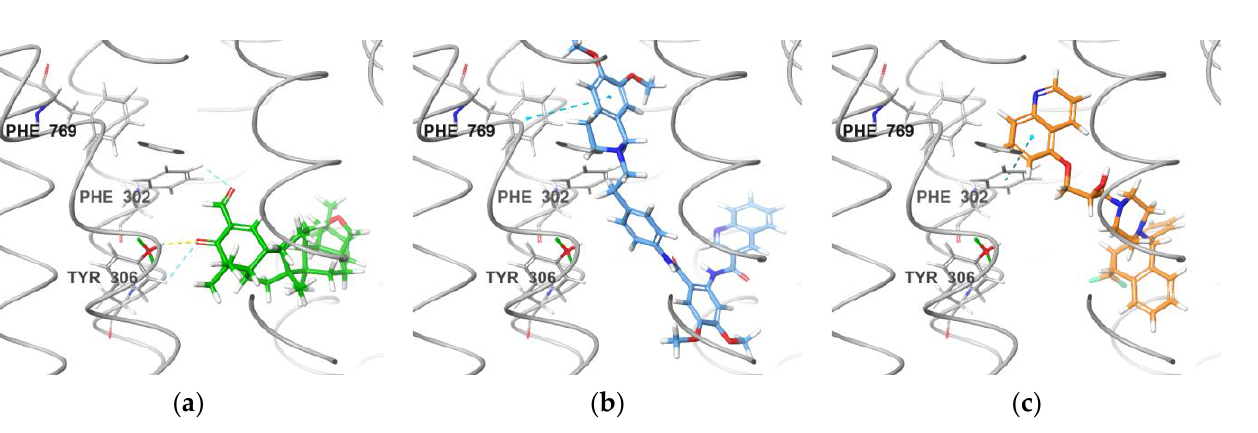
Figure 3. Comparison of the best GOLD docking conformations with human P-gp (PDB ID: 6QEE) for ( a ) OA ; ( b ) tariquidar; and ( c ) co-crystallized zosuquidar. Dotted line denotes Pi – pi stacking.